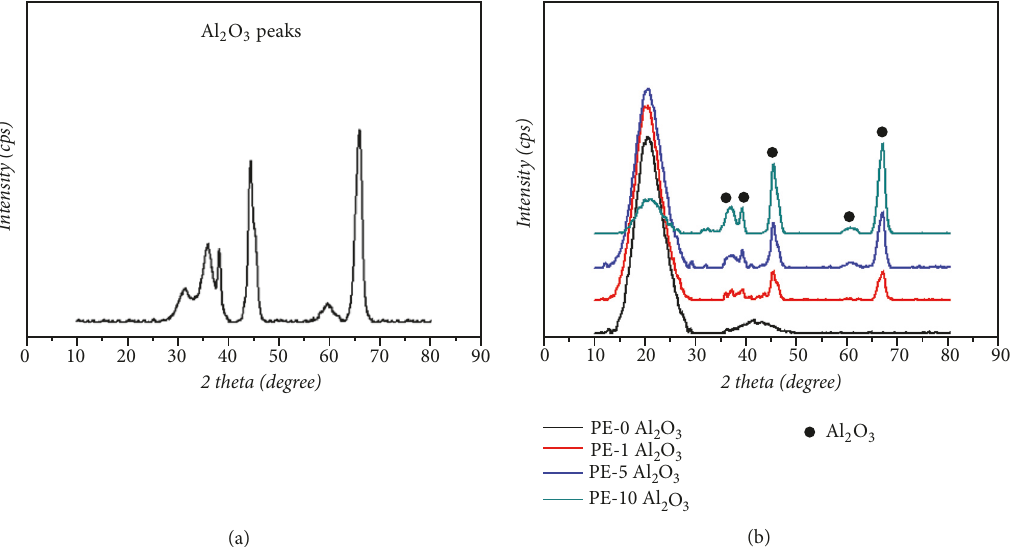
Figure 3: (a) XRD diffraction peaks of alumina particles and (b) XRD patterns of neat polyester and polyester composites containing